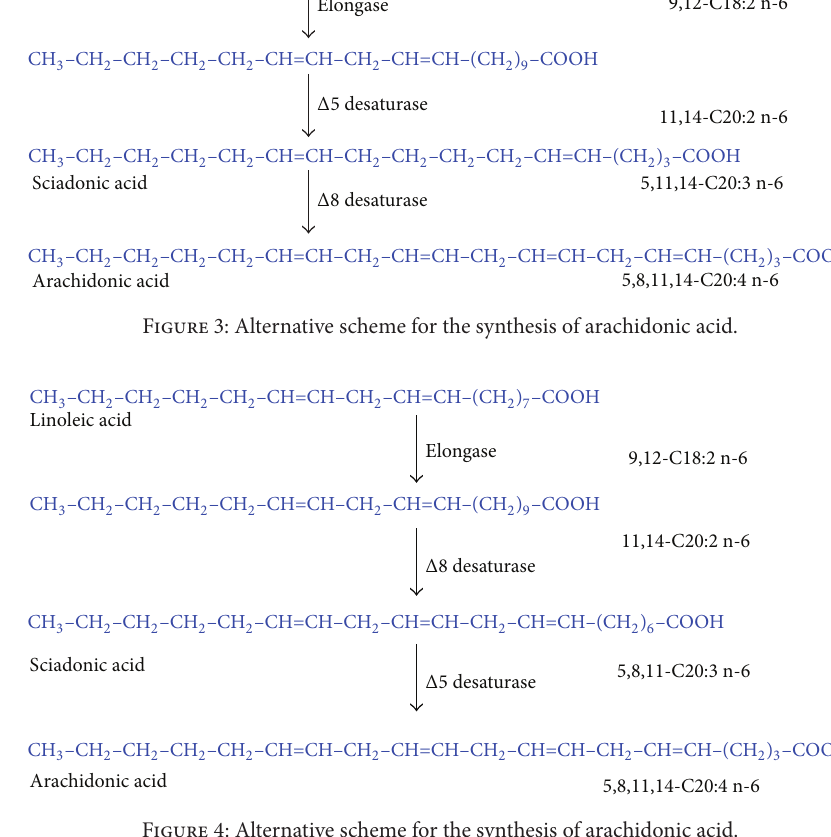
Figure 4: Alternative scheme for the synthesis of arachidonic